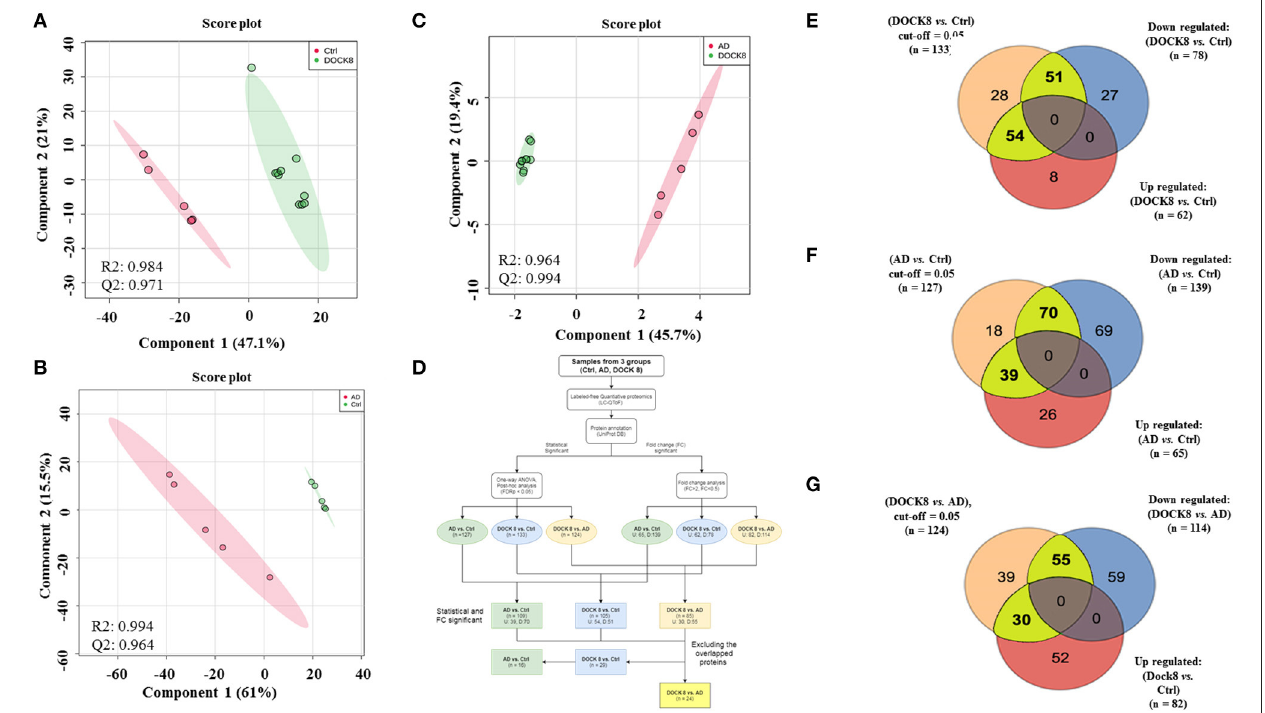
FIGURE 2 | Binary comparison between the study groups using PLS-DA plots, where (A) between Ctrl and DOCK8-deficient groups ( R 2 = 0.984 and Q 2 = 0.0.971), (B) AD and Ctrl groups ( R 2 = 0.994 and Q 2 = 0.0.964), and (C) between AD and Ctrl groups ( R 2 = 0.994 and Q 2 = 0.955). (D) A flow chart represents the data analysis workflow. The detected and identified proteins ( n = 275 proteins) were statistically and fold change analyzed (cut-off FDR p < 0.05) and fold change (cut-off 2), respectively. (E) 105 significant proteins (statistical and fold change) were found in DOCK8-deficient vs. Ctrl (54 upregulated and 51 downregulated), (F) 109 proteins in AD vs. Ctrl (39 upregulated and 70 downregulated), and (G) 85 proteins in AD vs. DOCK8-deficient (30 upregulated and 55 downregulated). DOCK8, dedicator of cytokinesis 8; AD, atopic dermatitis; PLS-DA, partial least square discrimination